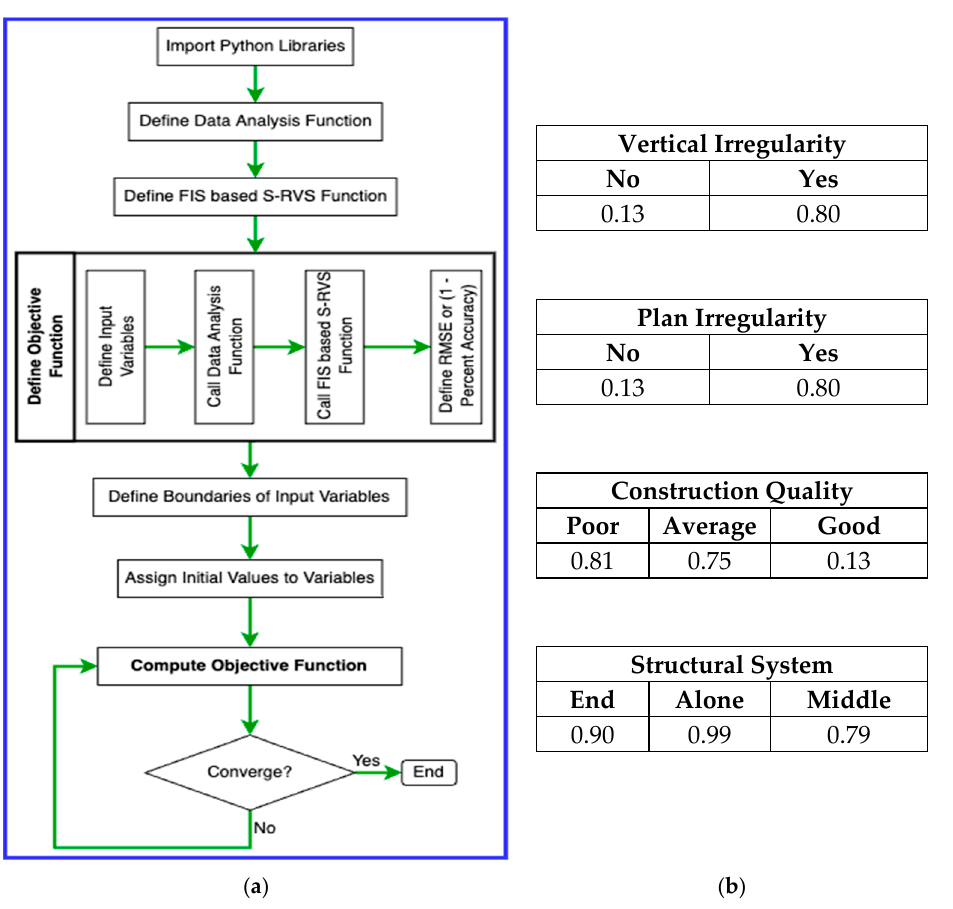
Figure 9. Transformed linguistic parameters (Bekta ş et al. [51]): ( a ) flowchart for optimizing transformation values and ( b ) transformed values.